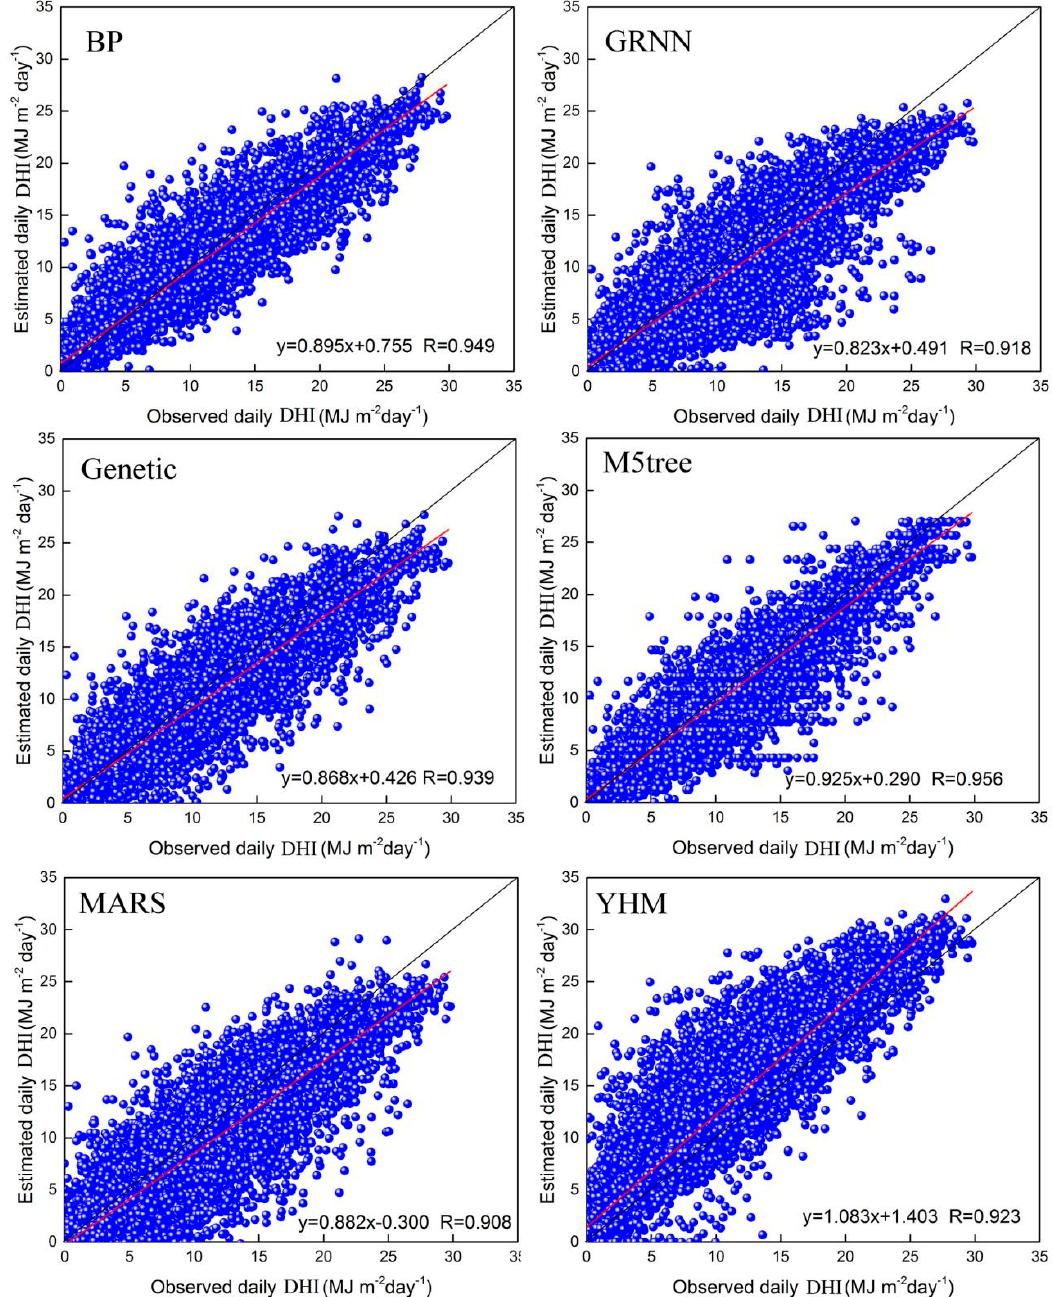
Figure 3. Results of correlation analysis of observed and estimated daily DHI at 16 CMA stations. Back propagation neural networks (BP); general regression neural networks (GRNN); genetic algorithm (Genetic); M5 model tree (M5Tree); multivariate adaptive regression splines (MARS); 343 Yang’s hybrid model (YHM).